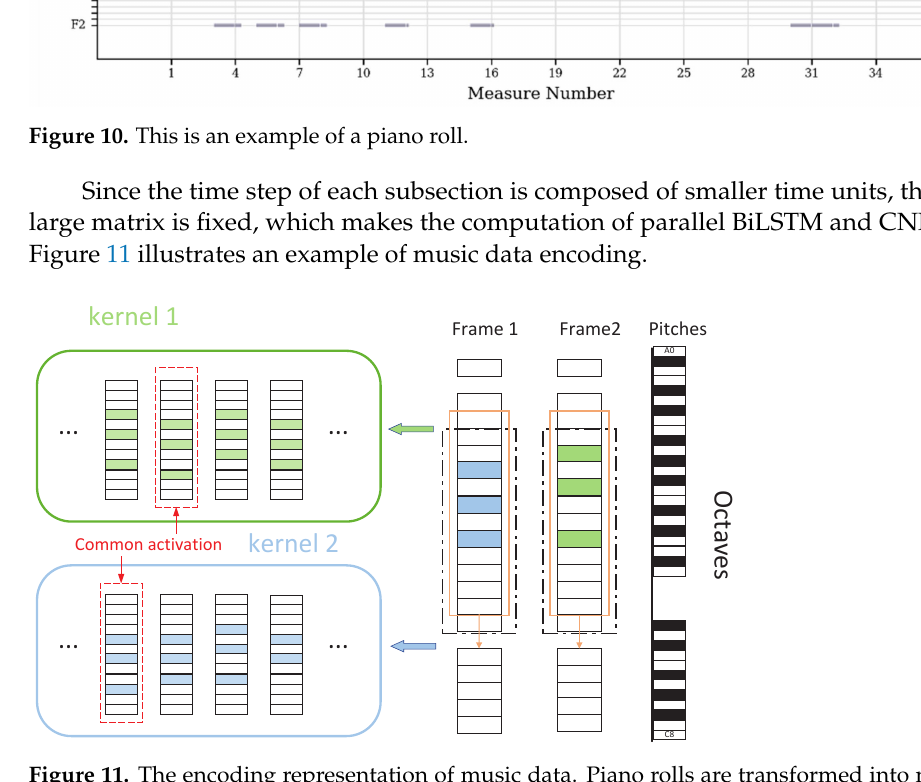
Figure 11. The encoding representation of music data. Piano rolls are transformed into multi-hot vectors for music data embedding